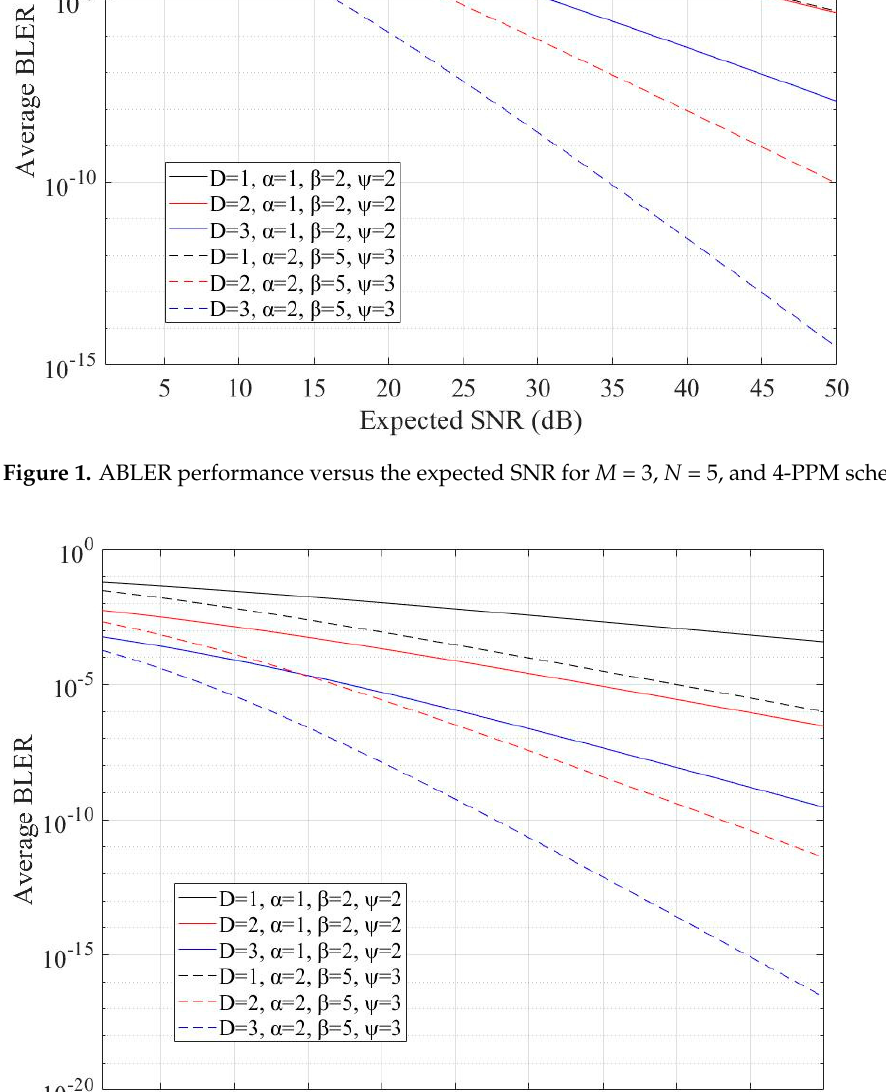
Figure 3. ABLER performance versus the expected SNR for M = 3, N = 5, and 8-PAM scheme.